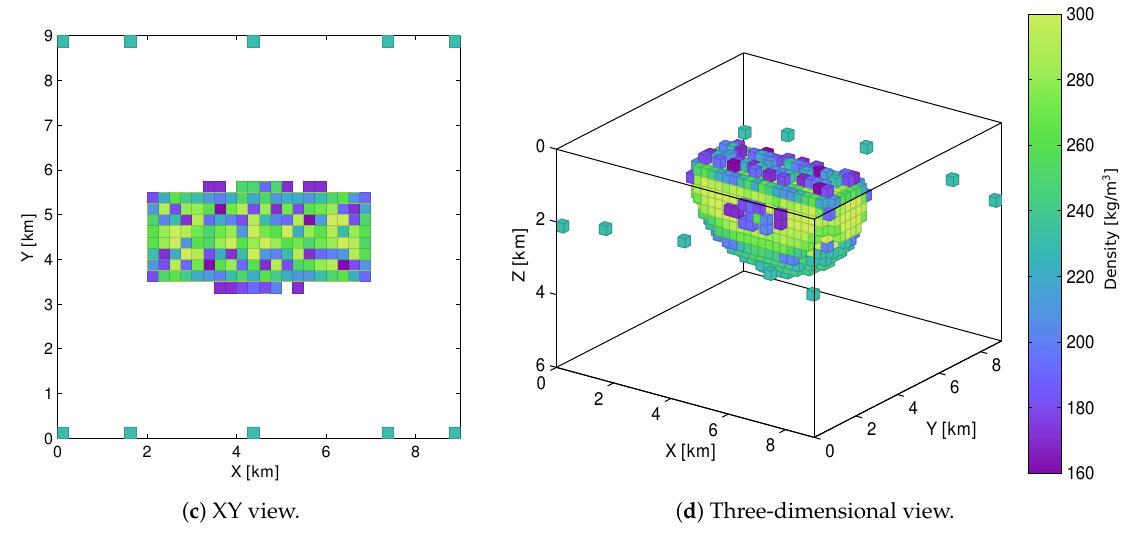
Figure 18. Inverted gradiometric T model.